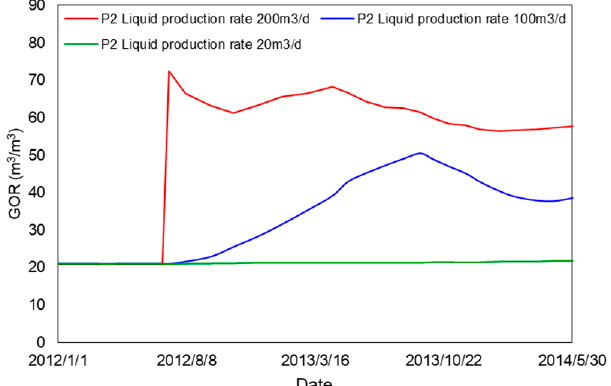
Figure 32. GOR of middle-well P2 with different liquid production rates.